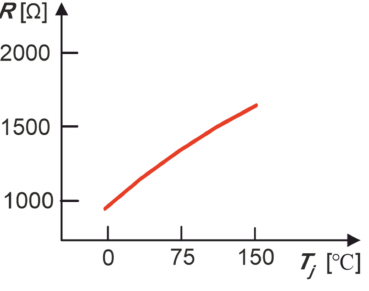
Figure 11. Cross-section of representative TO 220 case with Pt 1000 sensor glued in ( a ) two-wire circuit and ( b ) four-wire circuit. The proportions of the dimensions have not been maintained.